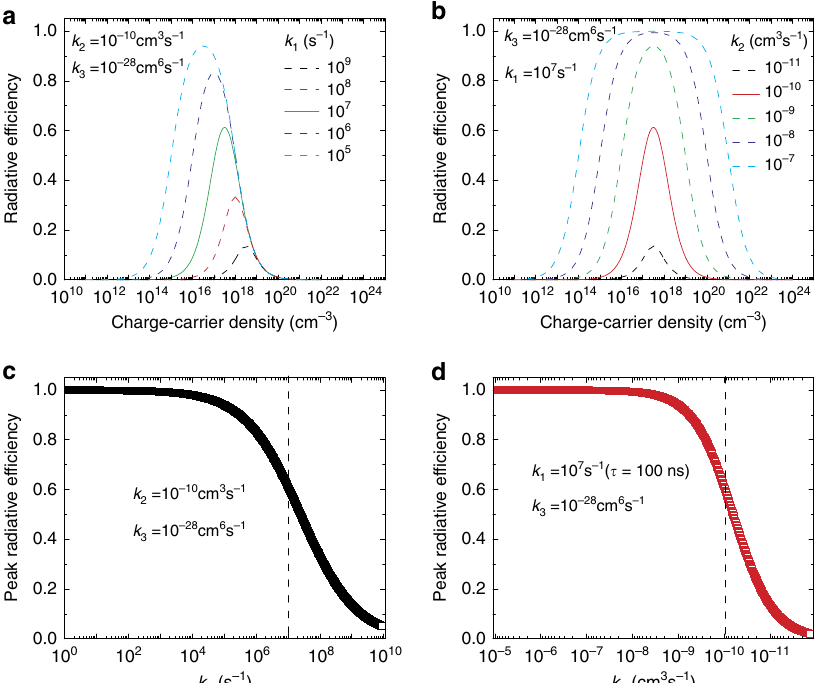
Figure 4 | The calculated luminescence quantum yield (QY) in three-dimensional (3D) lead-based perovskites. ( a ) Injected carrier density dependent luminescence QY with fixed reported bimolecular recombination constant ( k 2 ) and Auger recombination constant ( k 3 ), with several representative trap mediated recombination constants ( k 1 ). ( c ) With fixed k 2 and k 3 , the dependence of highest achievable luminescence QYon k 1 . The dashed line indicates the typical reported k 1 value (10 7 s (cid:2) 1 , 100ns). ( b ) Injected carrier density dependent luminescence QY with fixed k 1 and k 3 , but with different k 2 . ( d ) With fixed k 1 and k 3 , the dependence of highest achievable luminescence QY on k 2 . The dashed line indicates the typical reported k 2 value (10 (cid:2) 10 cm 3 s (cid:2) 1